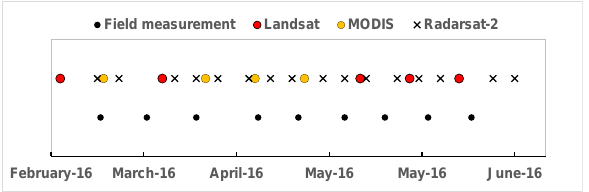
Figure 2. Correspondence between field measurements and imagery acquisition